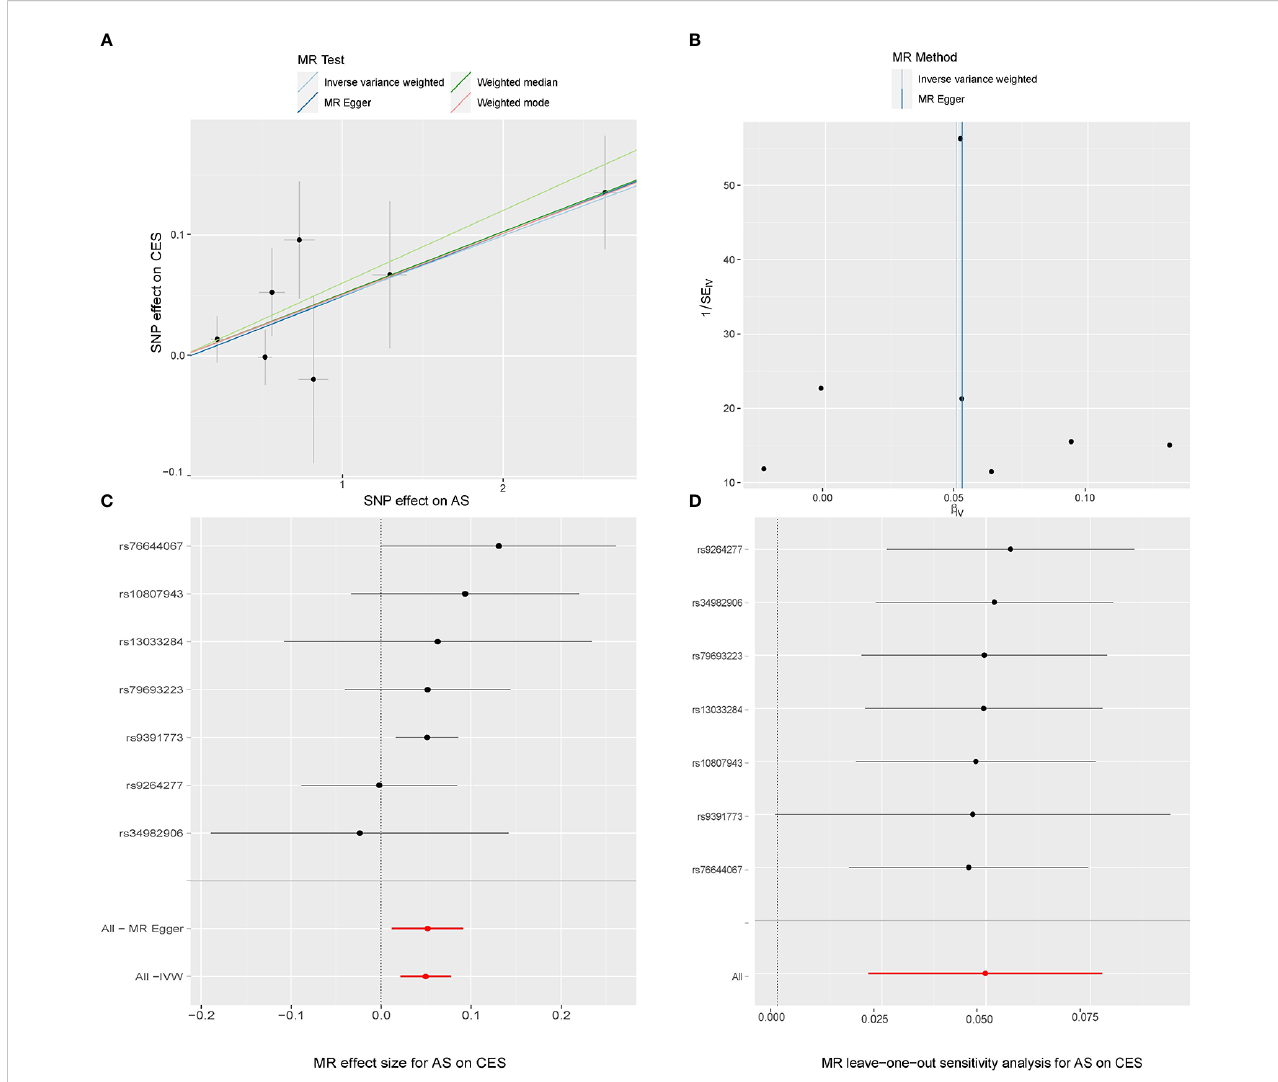
FIGURE 3 MR study of the effects of AS on CES. Scatter plot (A) , funnel plot (B) , forest plot (C) , and leave-one-out sensitivity analysis (D) of the effect of AS on